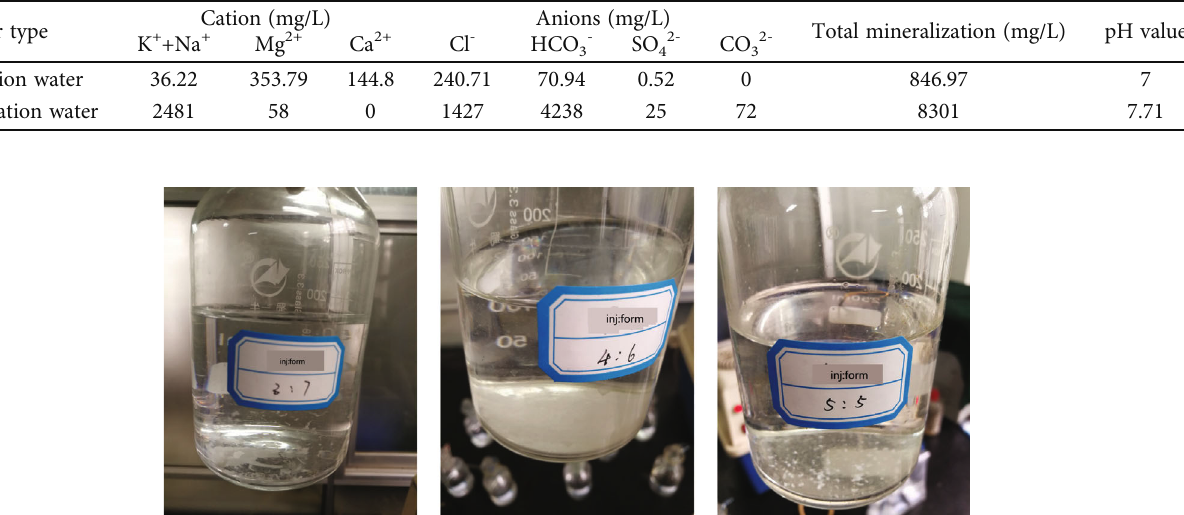
Table 2: Water sample ion concentration of the Weizhou 11-4N oil fi eld.